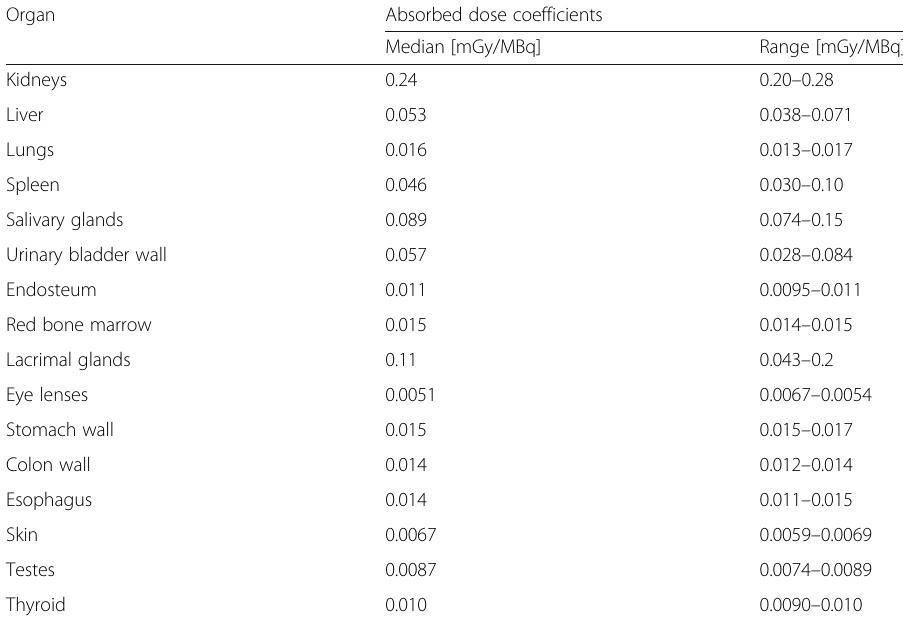
Table 2 The median values and the range of the absorbed doses per injected activity of [ 68 Ga]PSMA- 11 to organs for the six participants. Doses were calculated using the software IDAC-Dose